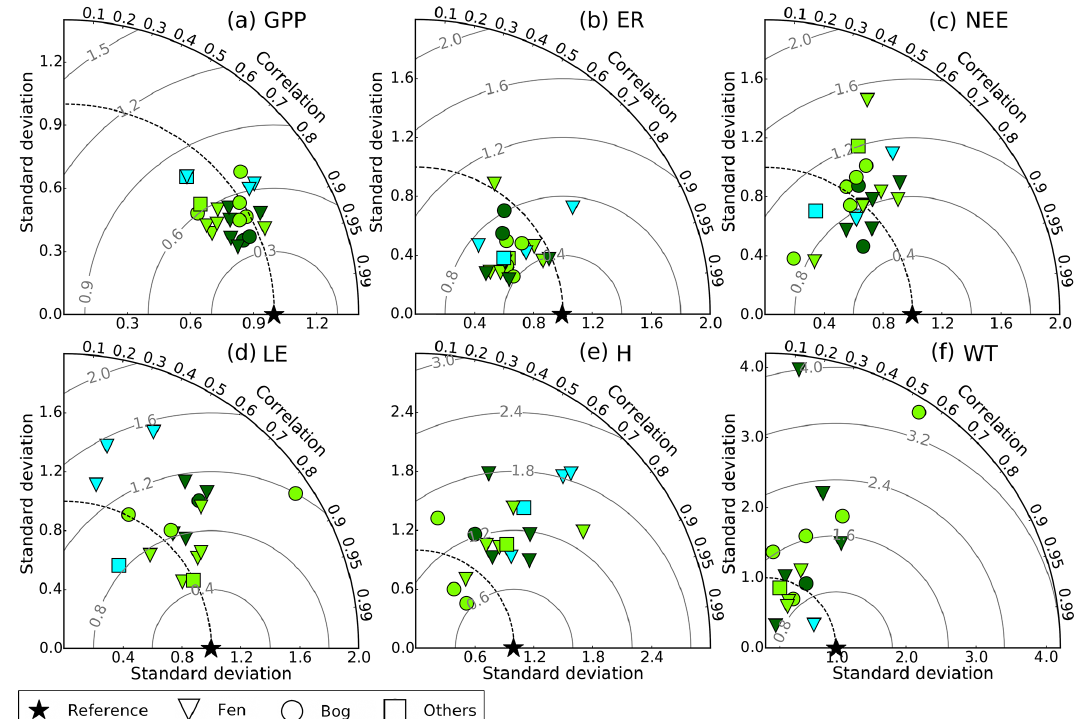
Figure 3. Taylor diagrams of (a) GPP (gCm − 2 day − 1 ); (b) ER (gCm − 2 day − 1 ); (c) NEE (gCm − 2 day − 1 ); (d) LE (Wm − 2 ); (e) H (Wm − 2 ); and (f) water table depth (cm). All statistics were calculated using daily averaged data. All points were normalized by dividing the standard deviation of model results by the standard deviation of the corresponding measurement; thus, the reference point is 1.0. Light green markers – temperate sites; dark green markers – boreal sites; blue markers – arctic sites.